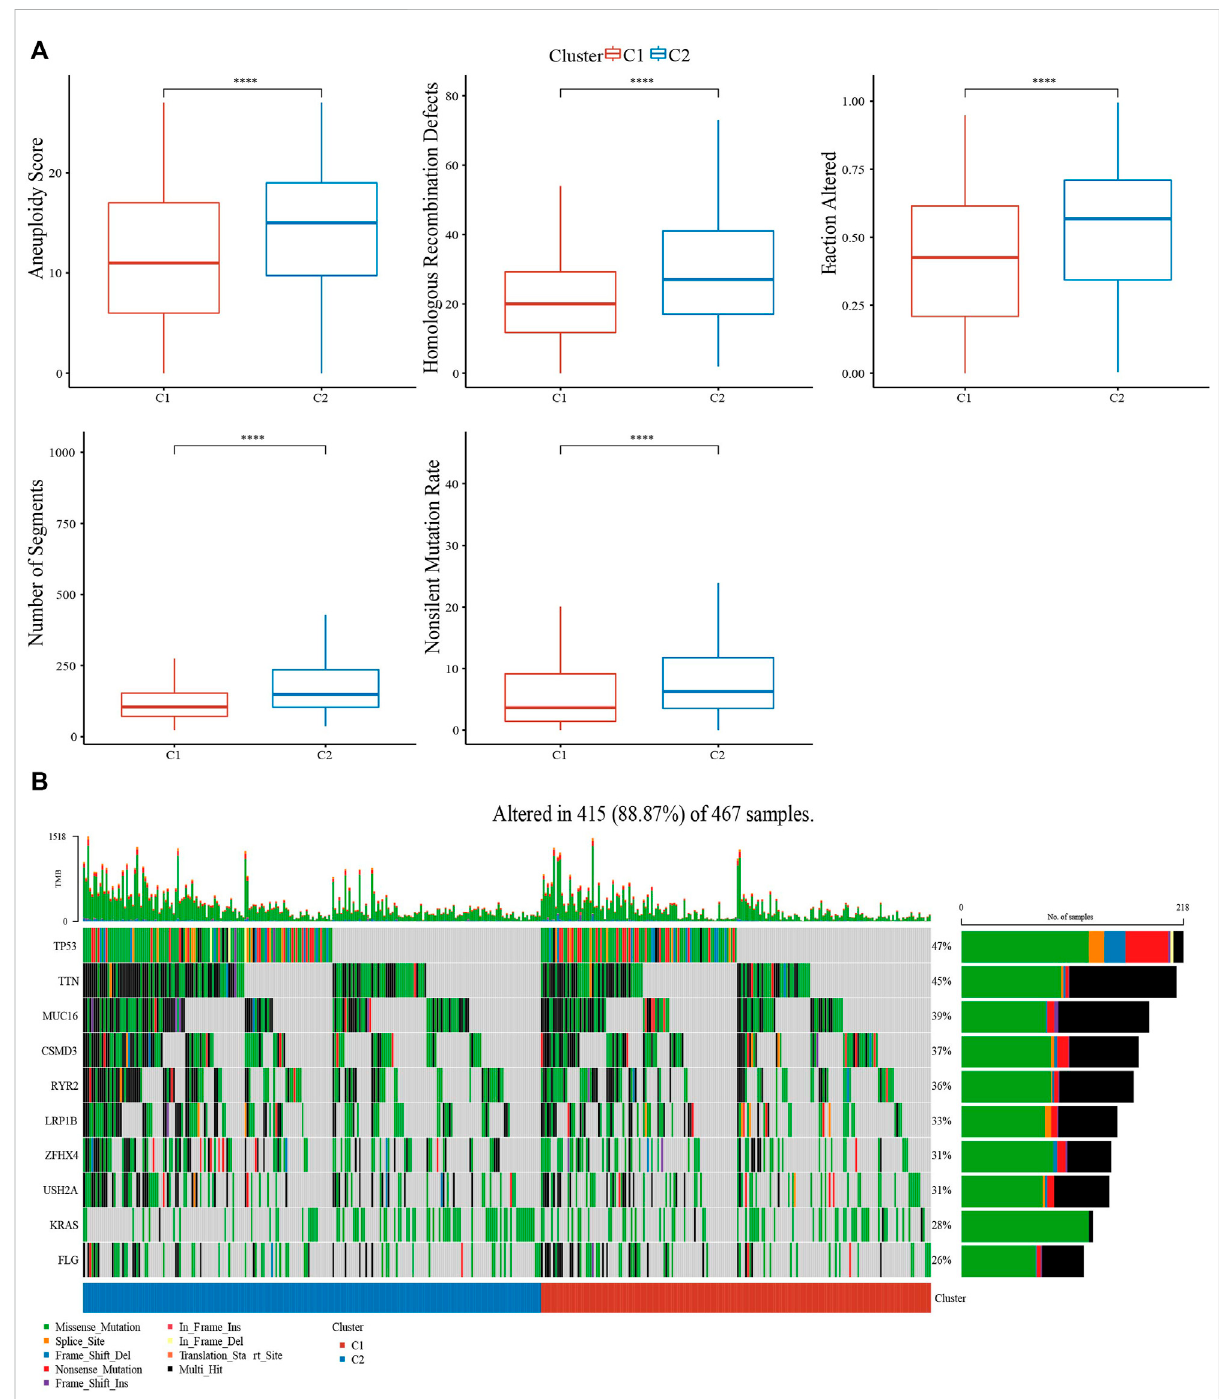
FIGURE 4 Genome analysis. (A) the analysis of Aneuploidy Score, Homologous Recombination Defects, Fraction Altered, number of segments, and non- silent mutation rate in C1 and C2. (B) Top 10 mutation genes in C1 and C2. *** p <